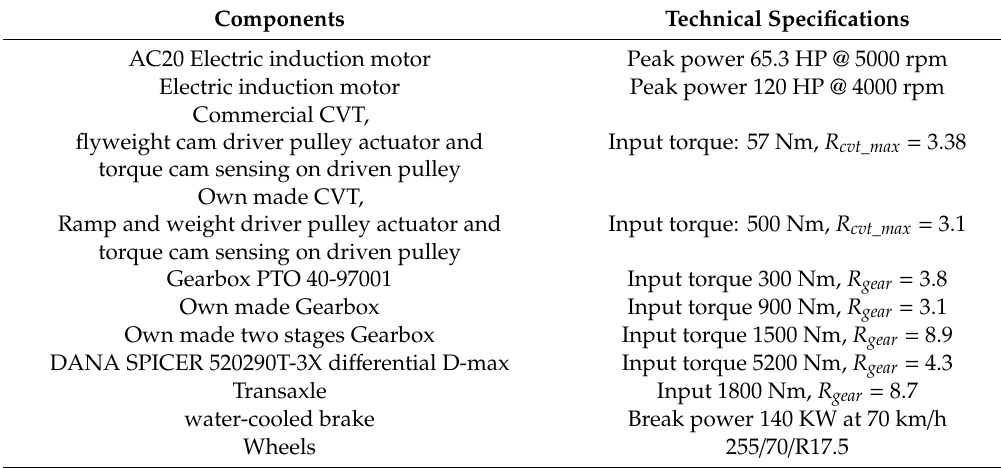
Table 2. Test bench and powertrain